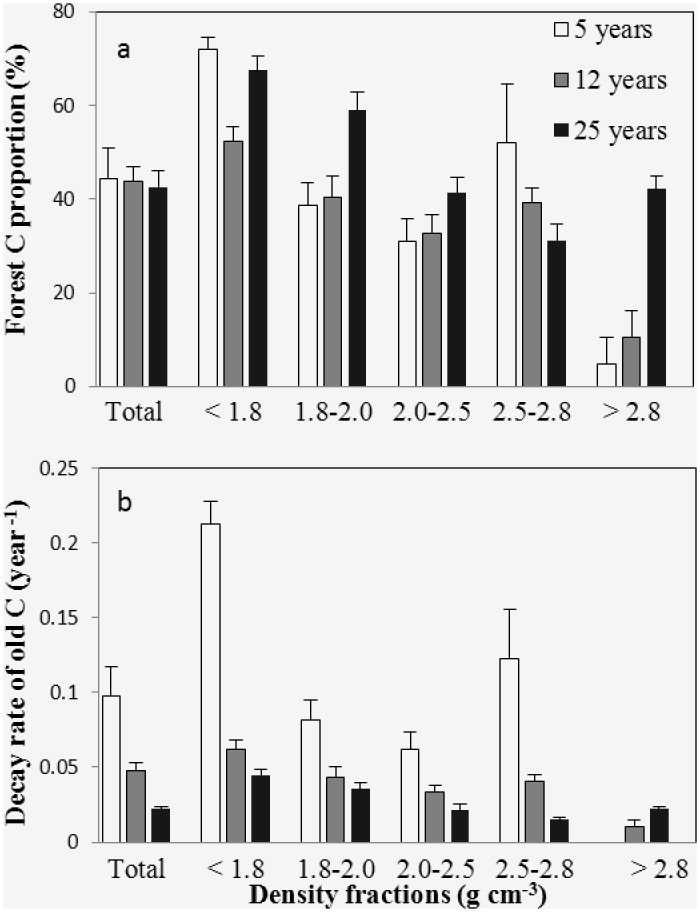
Forest C input (a) and decay rate (b) of old C (mean ± standard error) for bulk soil and density fractions of 5, 12 and 25 years forest.